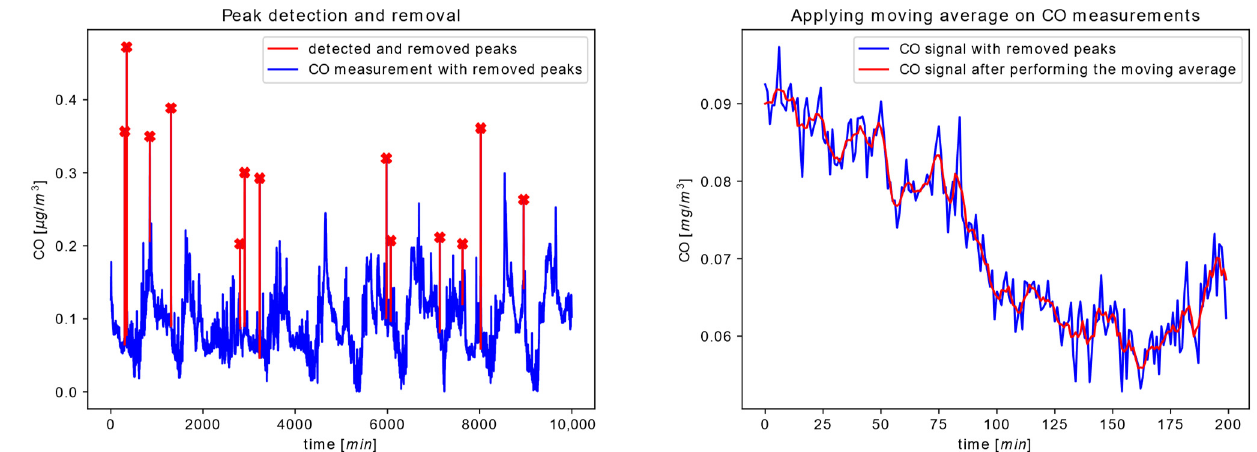
Figure 7. Time series data at the input and the output of the Peak elimination service ( left ) and Noise elimination service ( right ) performed on the CO sensor measurements.